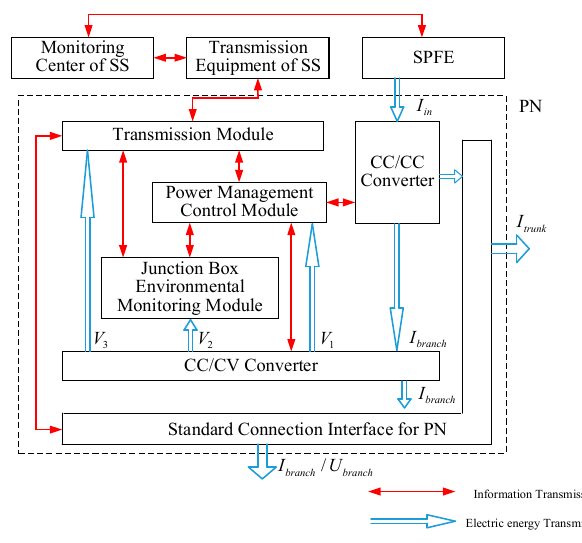
Figure 2. Internal structure diagram of the equipment in primary nodes (PNs).